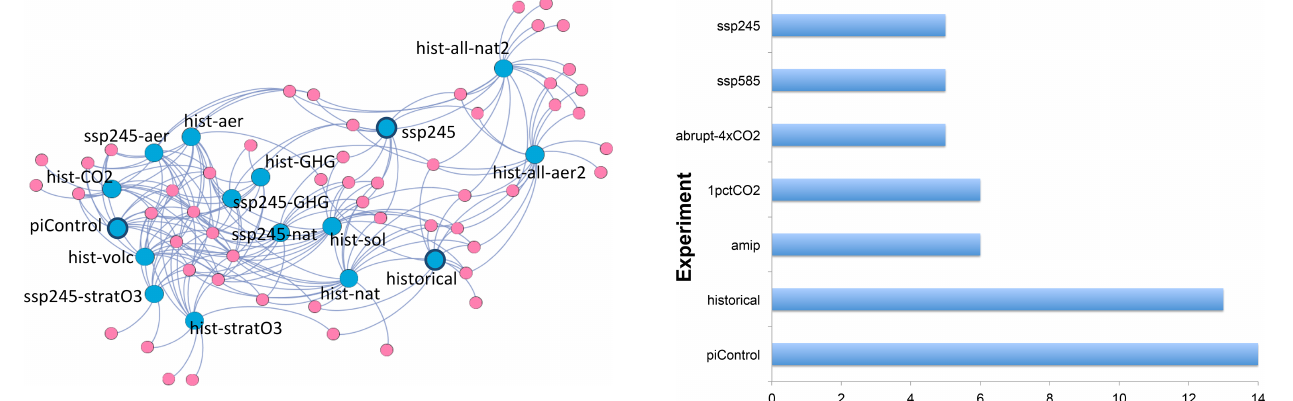
Figure 6. DAMIP experiments and forcing constraints. Individual experiments are represented by large blue dots. Lines connect each experiment to related forcing constraints, represented by pink dots. An example of a forcing constraint might be a constraint on atmo- spheric composition such as a requirement for a particular concen- tration of atmospheric carbon dioxide. In this figure three experi- ments are shown with dark blue borders (piControl, historical, and ssp245); these are experiments that are required by DAMIP but are not defined by DAMIP. The forcing constraints for these three “ex- ternal” experiments are used extensively by the DAMIP experiment suite.